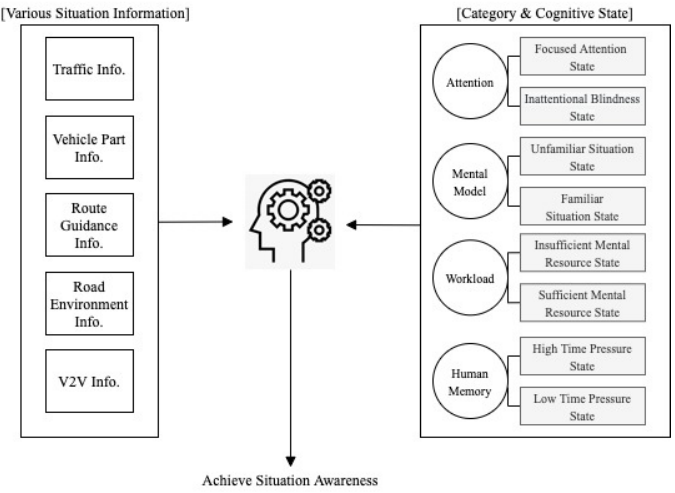
Figure 1. Cognitive states play an important role in perceiving situation information and in achieving situation awareness (Source: Own